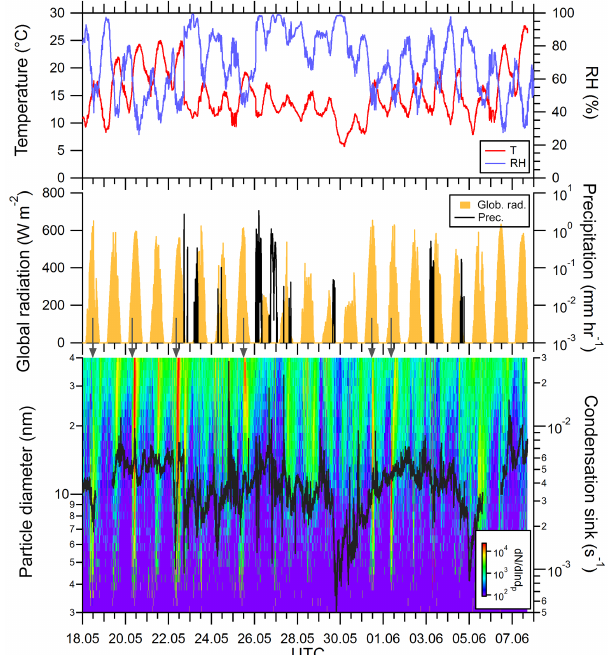
Figure 1. Overview of the different parameters measured between 18 May and 8 June 2014. Temperature ( T ) and relative humidity (RH) are shown in the upper panel, the center panel shows the global radiation and precipitation, and the bottom panel shows the number size distribution measured by the nano-DMA together with the con- densation sink (black line). Gray arrows above the bottom panel indicate days when significant NPF was observed.